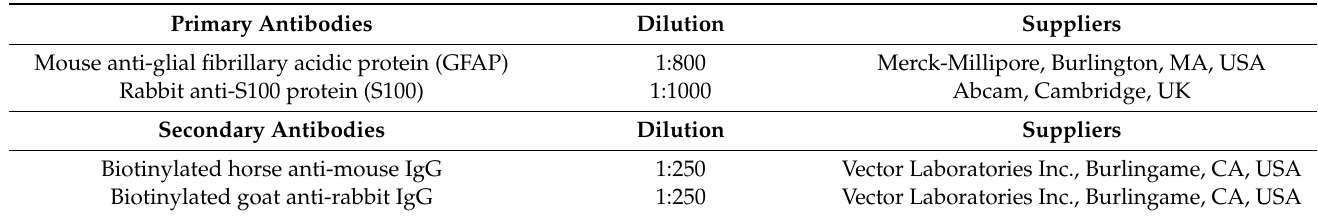
Table 1. Primary and secondary antibodies for immunohistochemical